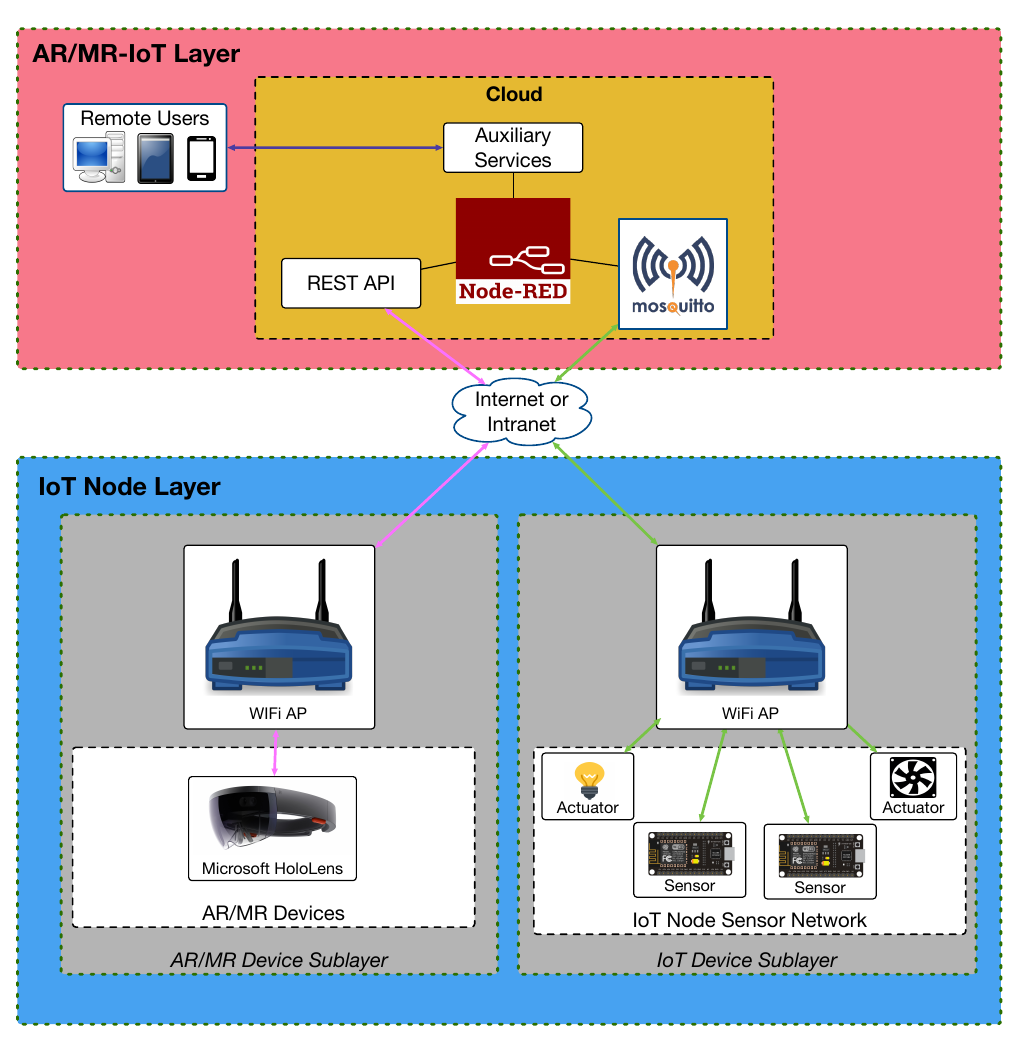
Figure 4. Implemented communications